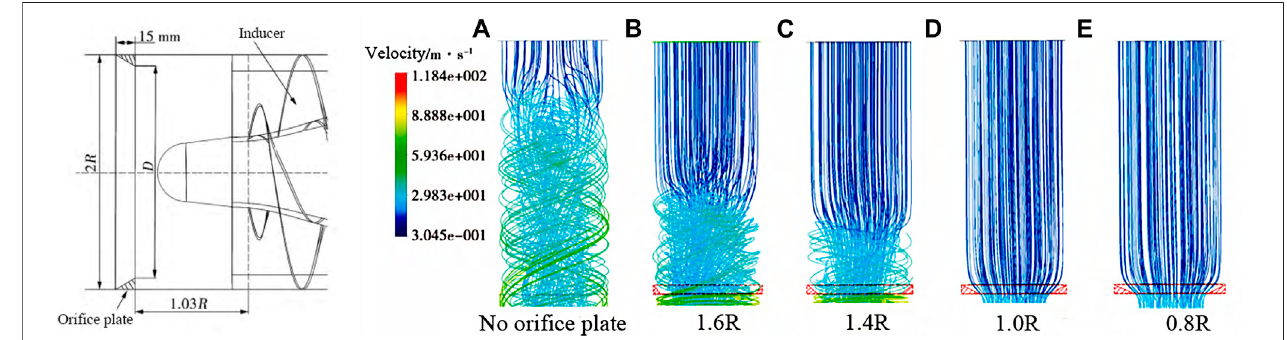
FIGURE9| Structureoftheori fi ceplateandstreamlinedistributionoftheinletsection(ChengfanShi,2019). (A) Withoutori fi ceplate. (B) D=1.6R. (C) D=1.4R. (D) D = 1.0R. (E) D = 0.8R.